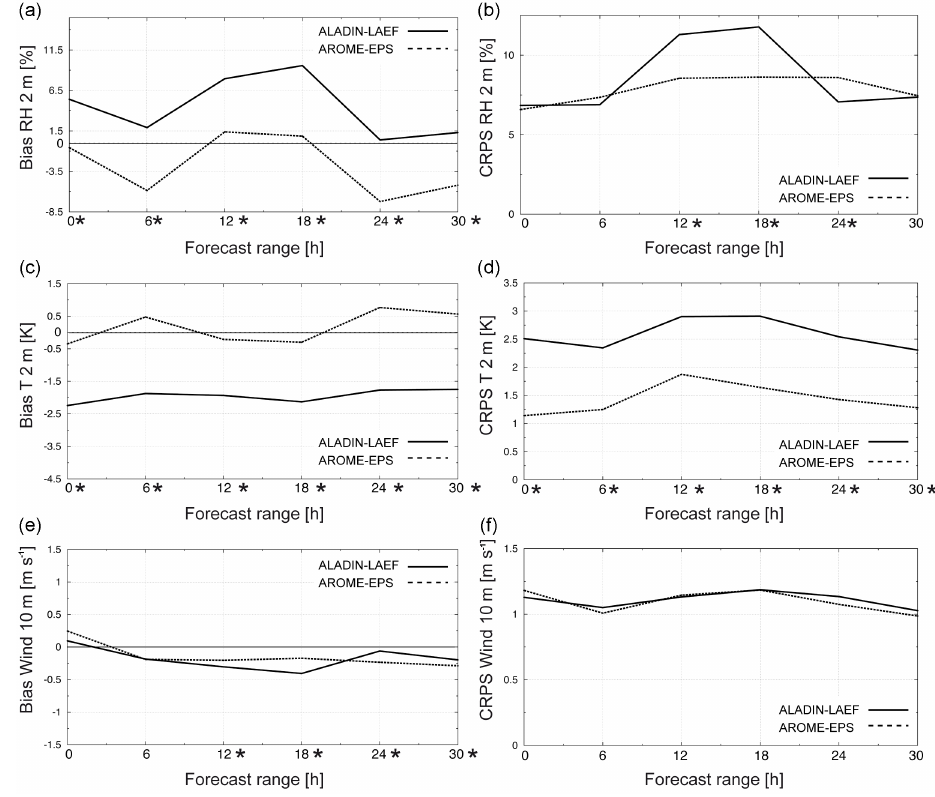
Figure 4. Bias of the ensemble means (left panel) and CRPS (right panel) for 2m relative humidity (top), 2m temperature (middle), and 10m wind speed (bottom) for the period of 15 May–15 August 2011 of AROME-EPS (dotted line) and ALADIN-LAEF (solid line), both verified over the AROME domain. Lead times, which are marked with asterisks (*) indicate results with significant differences between the